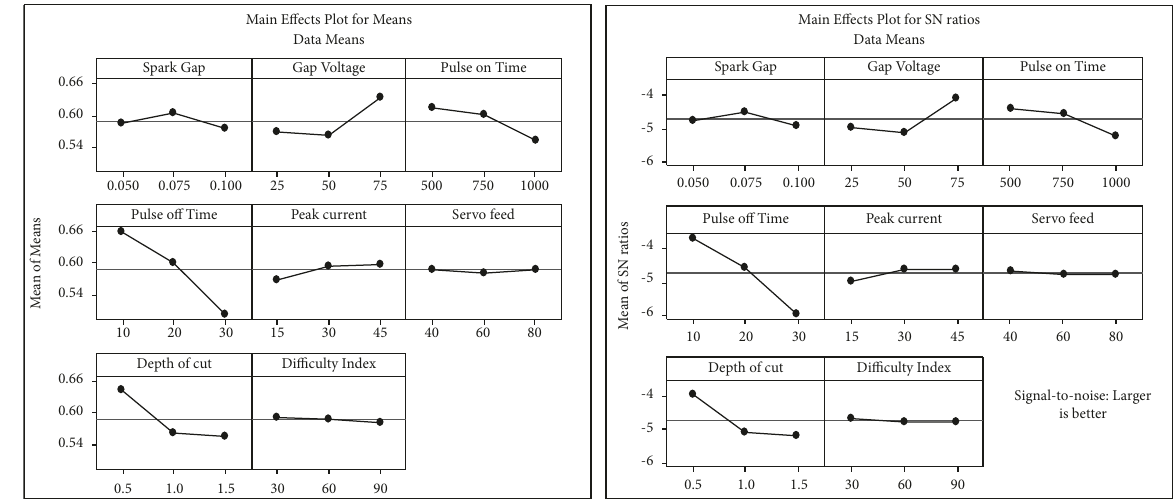
Figure 11: Main effect plot and S/N plot for overall grey relational grade (OGRG).